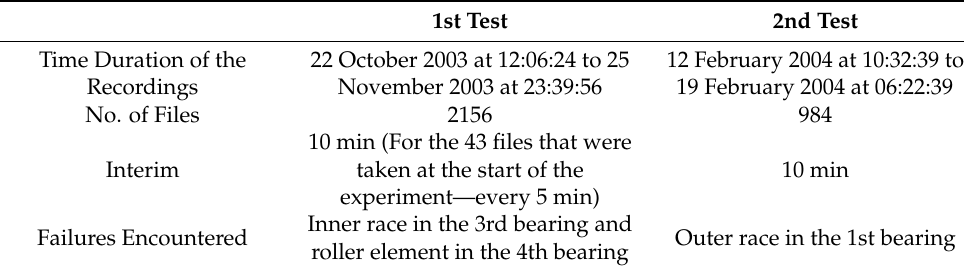
Table 1. Describes the test-to-failure experiment details for Tests 1 and